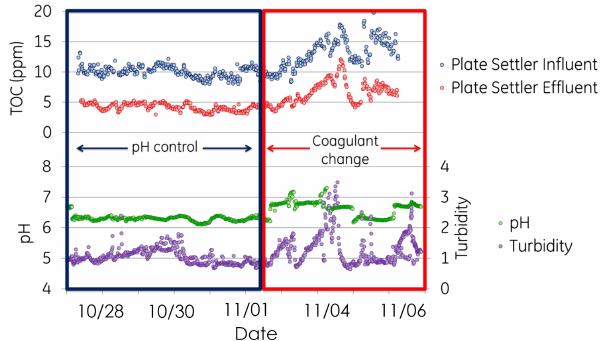
Figure 4. TOC removal efficiencies for pH control and coagulant